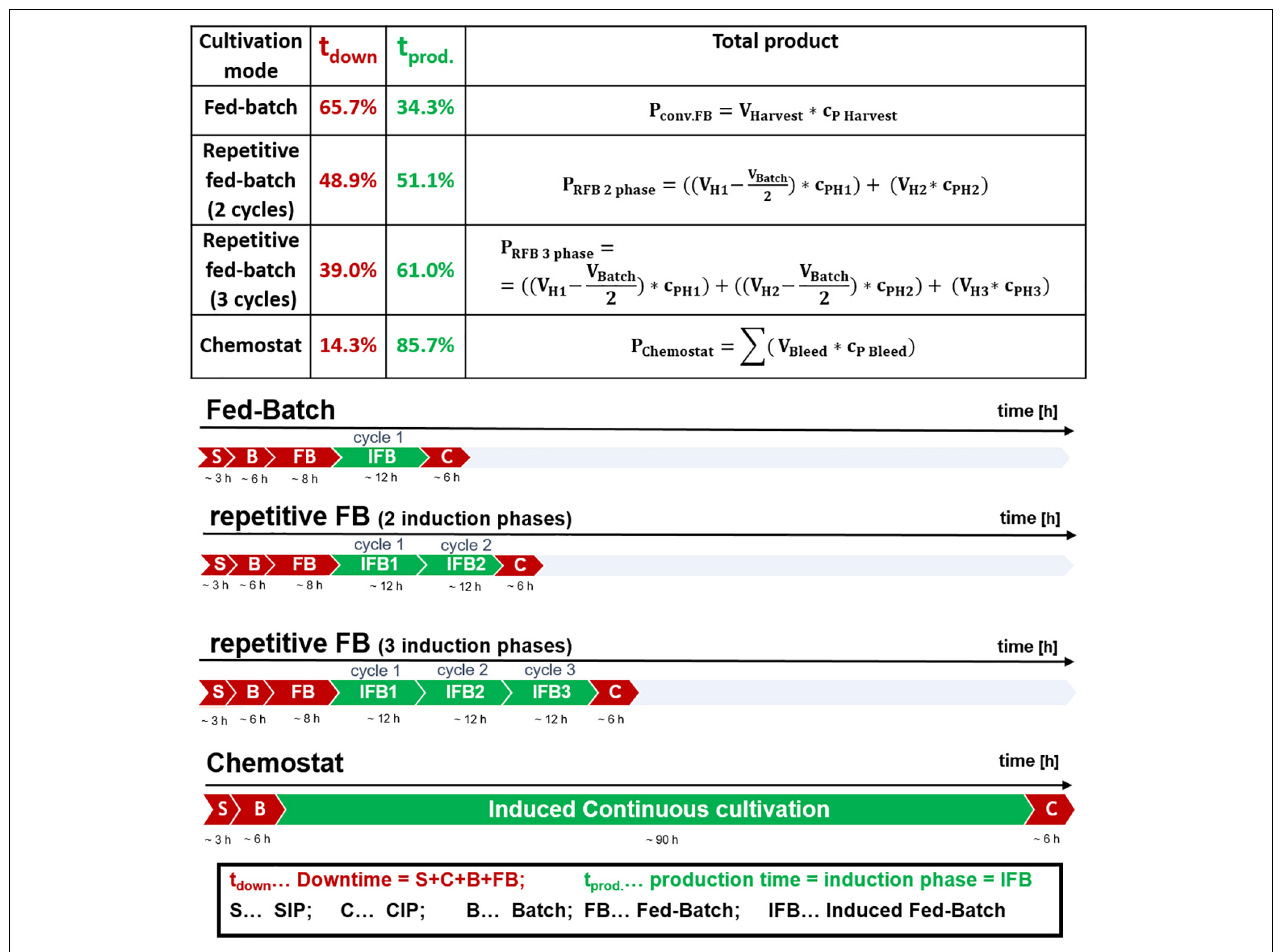
FIGURE 1 | Comparison of cultivation durations of a fed-batch, a repetitive fed-batch consisting of two cycles, a repetitive fed-batch consisting of three cycles and a chemostat process; effective production time vs. downtime for a 10 m 3 fermenter scale is given for each process in percent relative to total process time; steam in place (SIP), cleaning in place (CIP).